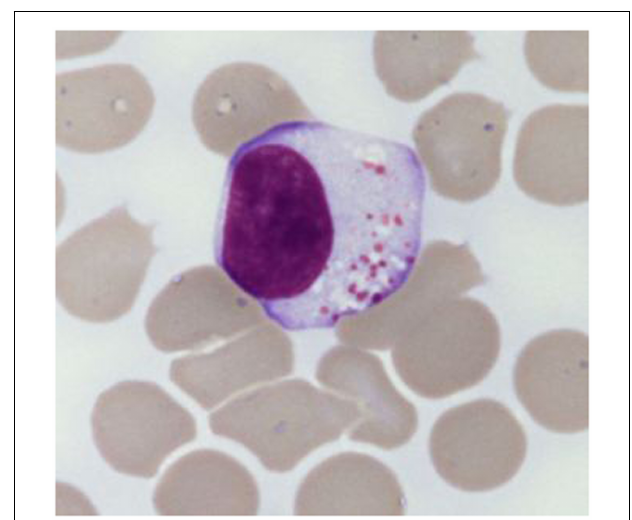
FIGURE 1 |Typical large granular lymphocyte morphology as detected in a CLPD-NK patient